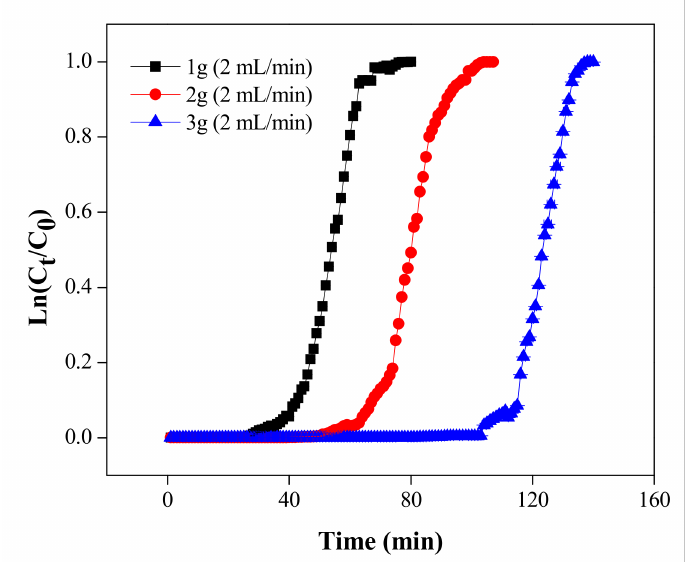
Figure 10. Cr(VI) adsorption breakthrough with different adsorbent masses.